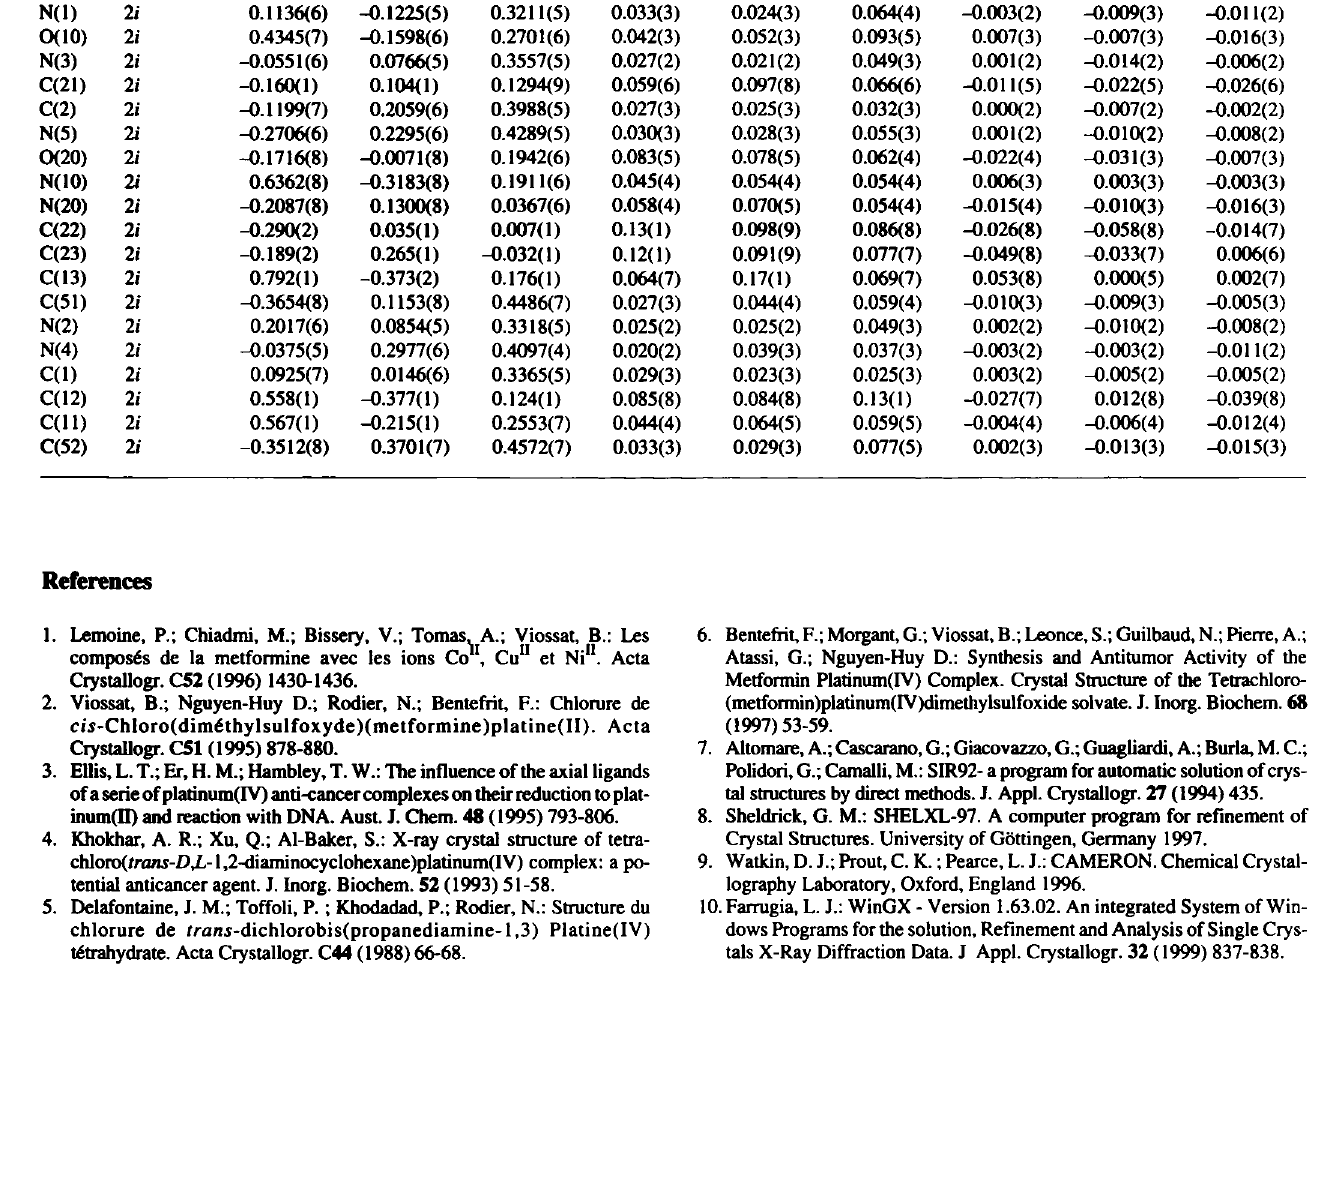
Table 3. Atomic coordinates and displacement parameters (in A 2